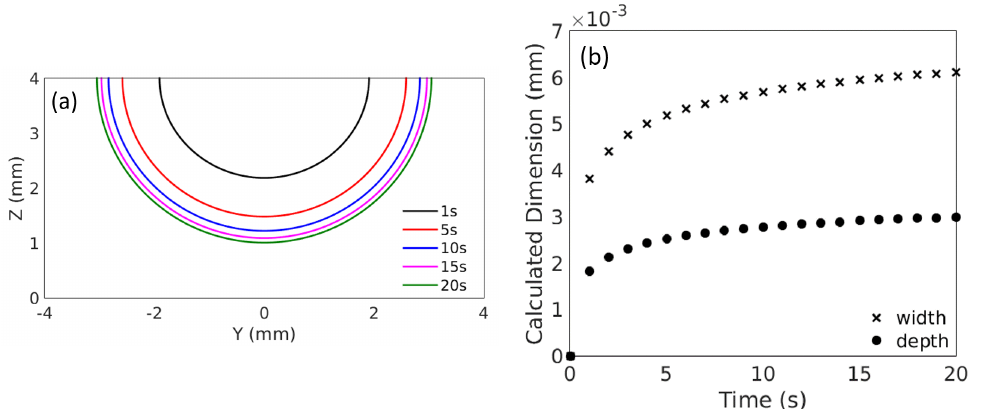
Figure 7. Temporal variation of melt pool dimensions for a CMSX-4 (cid:114) specimen fabricated using P = 900 W and v = 0.25 mm/s: ( a ) longitudinal cross section with the liquidus isotherm showing the variation in melt pool dimensions with time and ( b ) variation of melt pool depth and width with